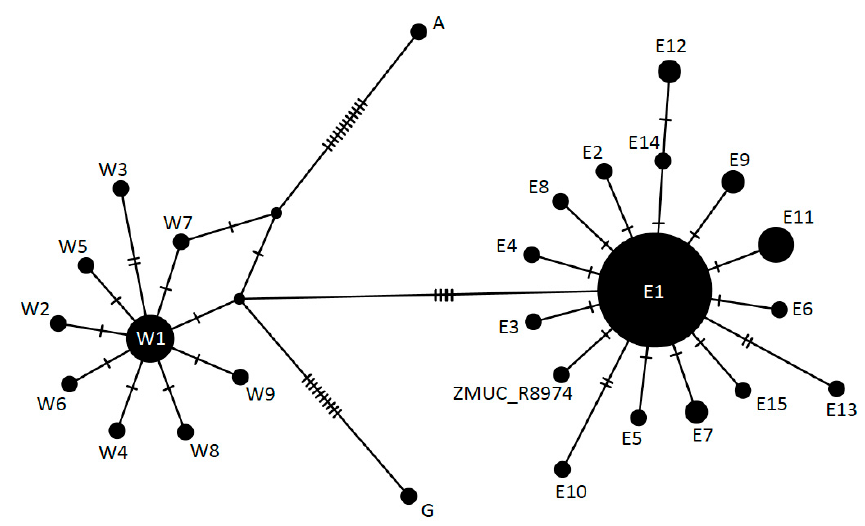
Figure 3. Unrooted median joining network of Z. longissimus mtDNA haplotypes, based on 94 concatenated sequences ( cytb + coxI , 1638 bp). Nomenclature according to Musilová et al. [19]: E = Eastern, W = Western, G = Greek, A = Asian. The two Danish individuals are found in the Eastern clade. HK2489 shows the previously described E1 haplotype and ZMUC R8974 shows a new haplotype derived from E1.